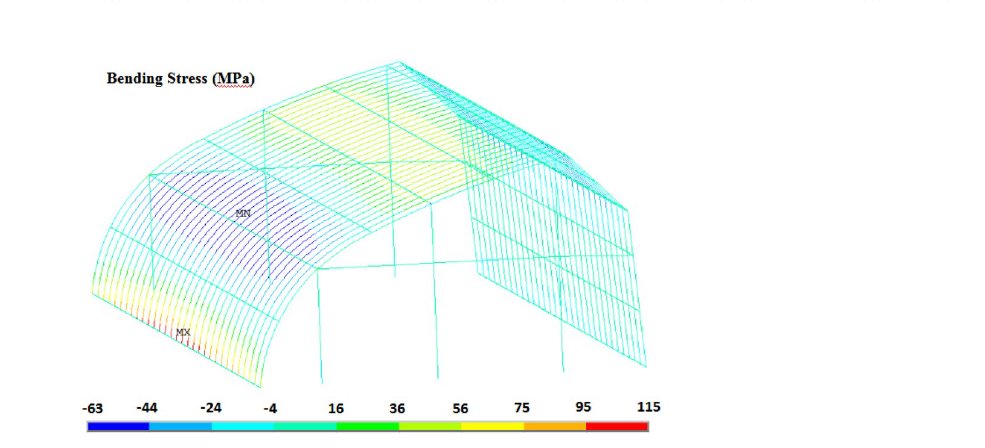
Figure 8. Stress time history of the element with maximum axial stress.